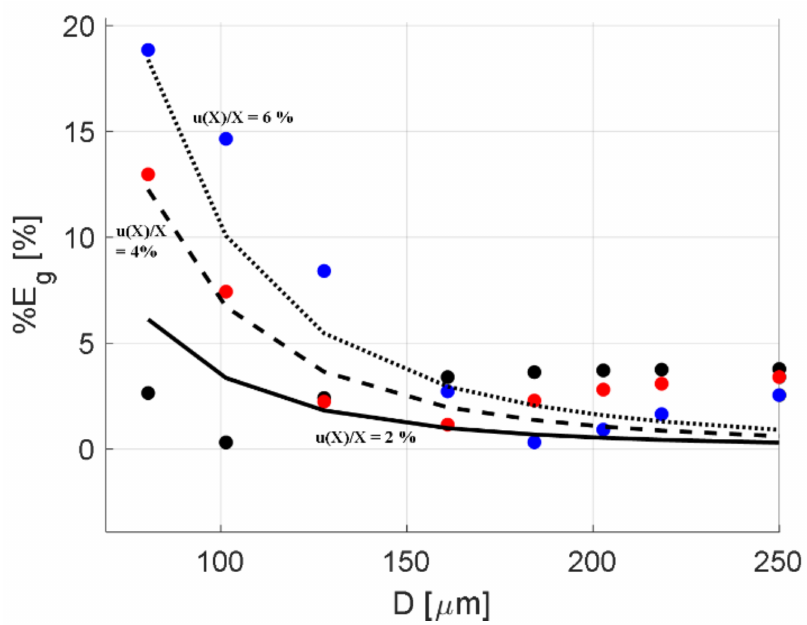
Figure A1. Relative error %E g between set local breakup frequency and estimated global breakup frequency as a function of drop diameter, D for case B (markers) at three different flow conditions: U g = 1.5 m/s ( black ), U g = 3.0 m/s ( red ) and U g = 6.0 m/s ( blue ). The results are compared to the general uncertainty management framework applied to the uncorrected method (Equation (A3)), assuming three different input uncertainties: u(X)/X = 2% (solid), 4% (dashed), 6% (dotted). Note that the uncertainty propagation turns a small uncertainty in the input ( N I /N I, 0 ) into a large uncertainty in the estimated breakup frequency when the ( N I /N I, 0 ) is relatively small (i.e., little breakup